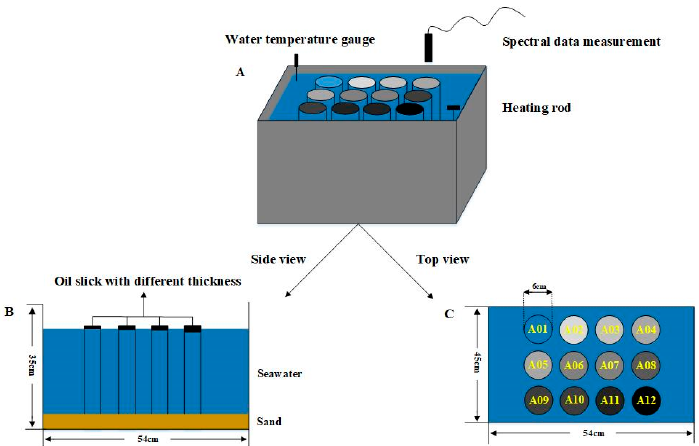
Figure 1. Diagram of the experimental observation setup.